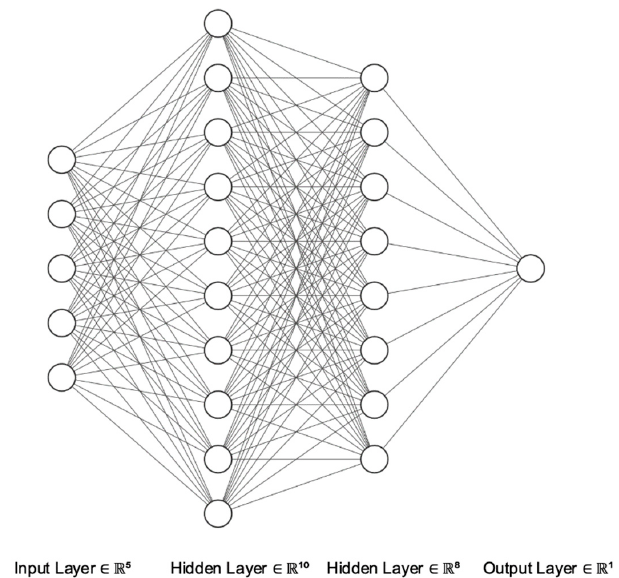
Figure 1. The topology of MLP neural network.